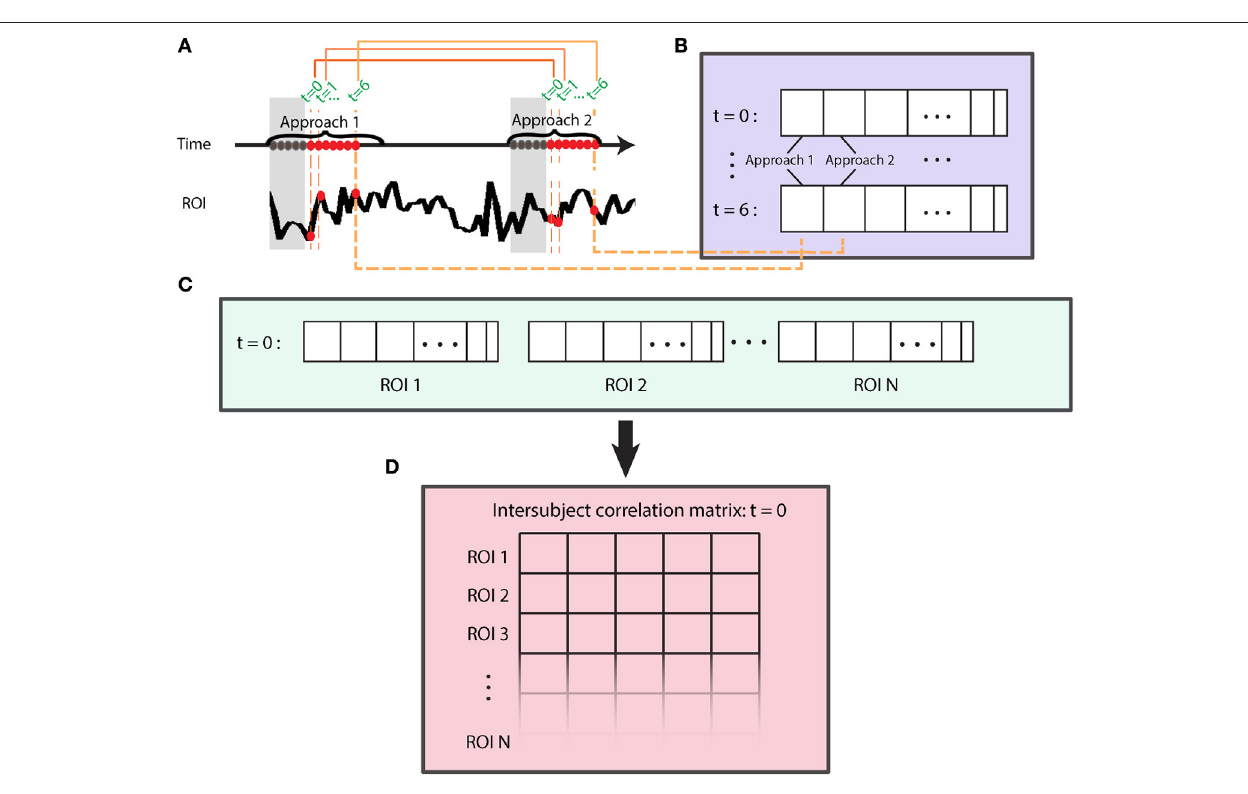
FIGURE 4 | Evaluation of intersubject functional connectivity dynamics. Intersubject correlation matrices were computed at each time point of approach and retreat segments, separately. (A) Time was used to index data during approach and retreat (not shown) segments. To account for the hemodynamic delay, we discarded the first 5s of each segment (gray part). (B) A time series vector at t = 0 was generated by concatenating all of the t = 0 samples (across same-condition segments across blocks and runs); likewise, for t = 1, and so on. (C) At a given time t , time series vectors were used to compute the intersubject correlation matrix (D) . This process is shown for t = 0 and repeated for times t = 1,…,6 for approach and t = 1, …5 for